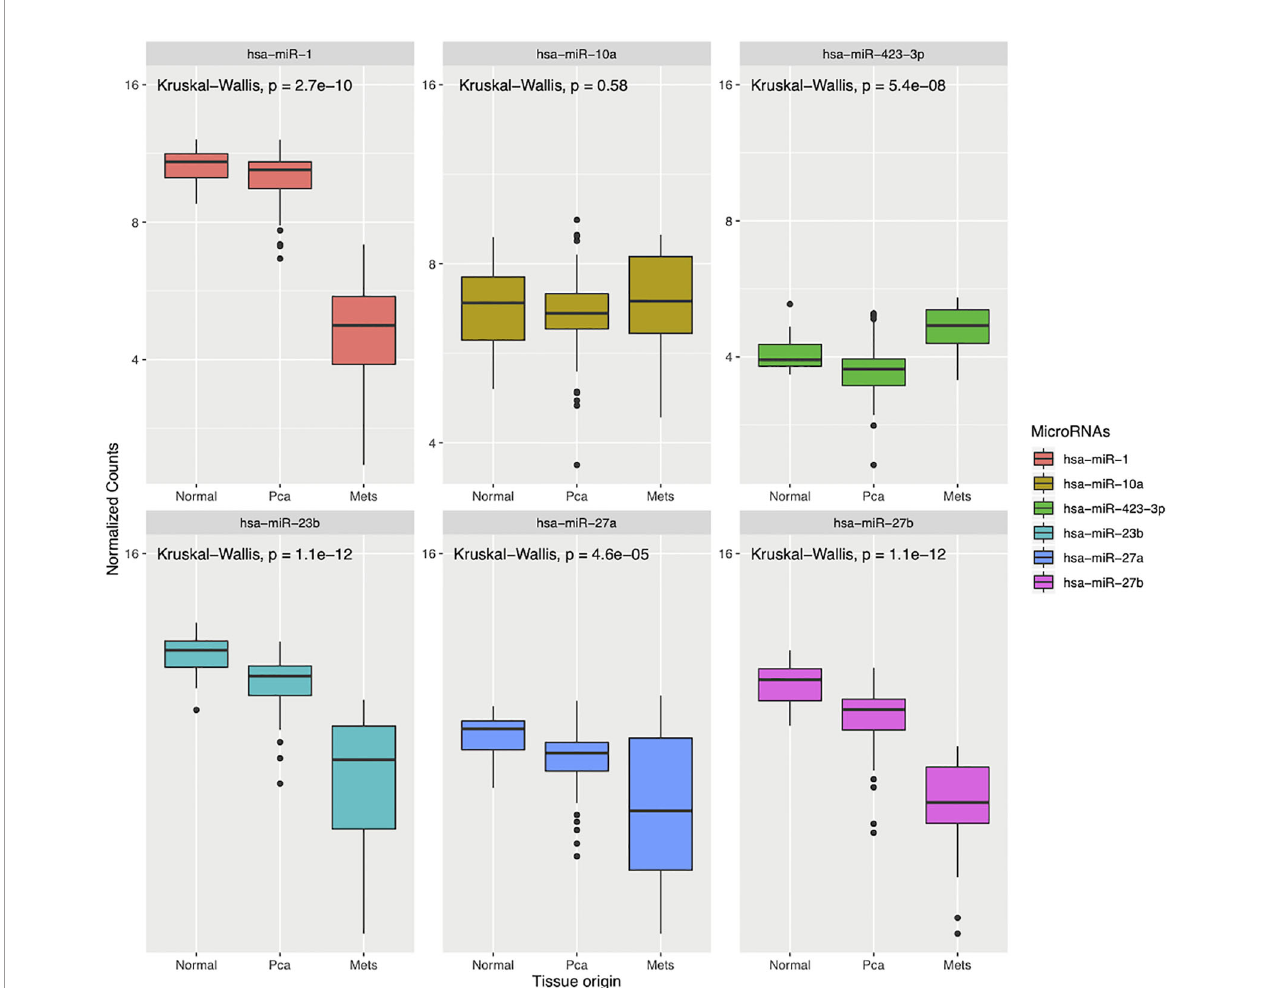
FIGURE 8 | Expression of the differentially expressed microRNAs found in our analysis in the Taylor et al. dataset grouped by normal, prostate cancer (PCa) and metastatic samples (Mets), n =